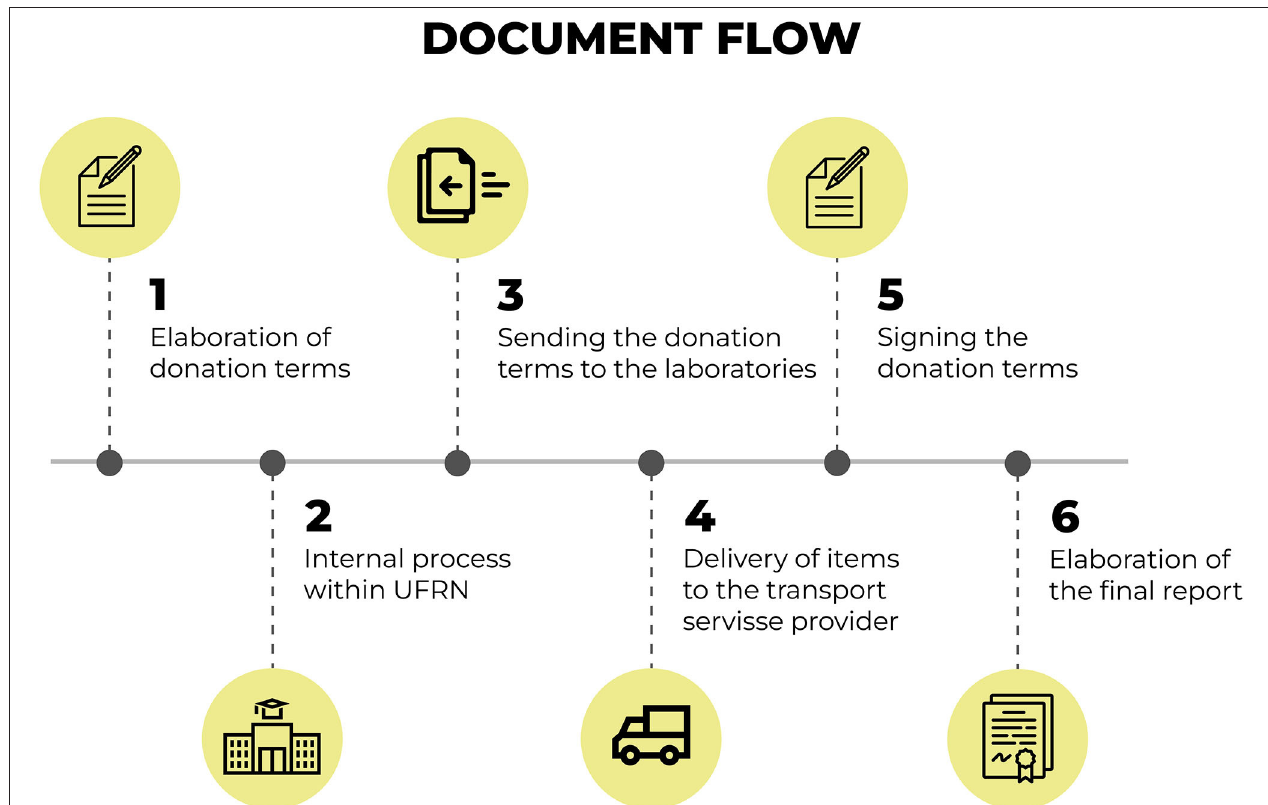
FIGURE 7 | Flow for the documentation that permeates the distribution of equipment and materials. Source: graphic developed by the